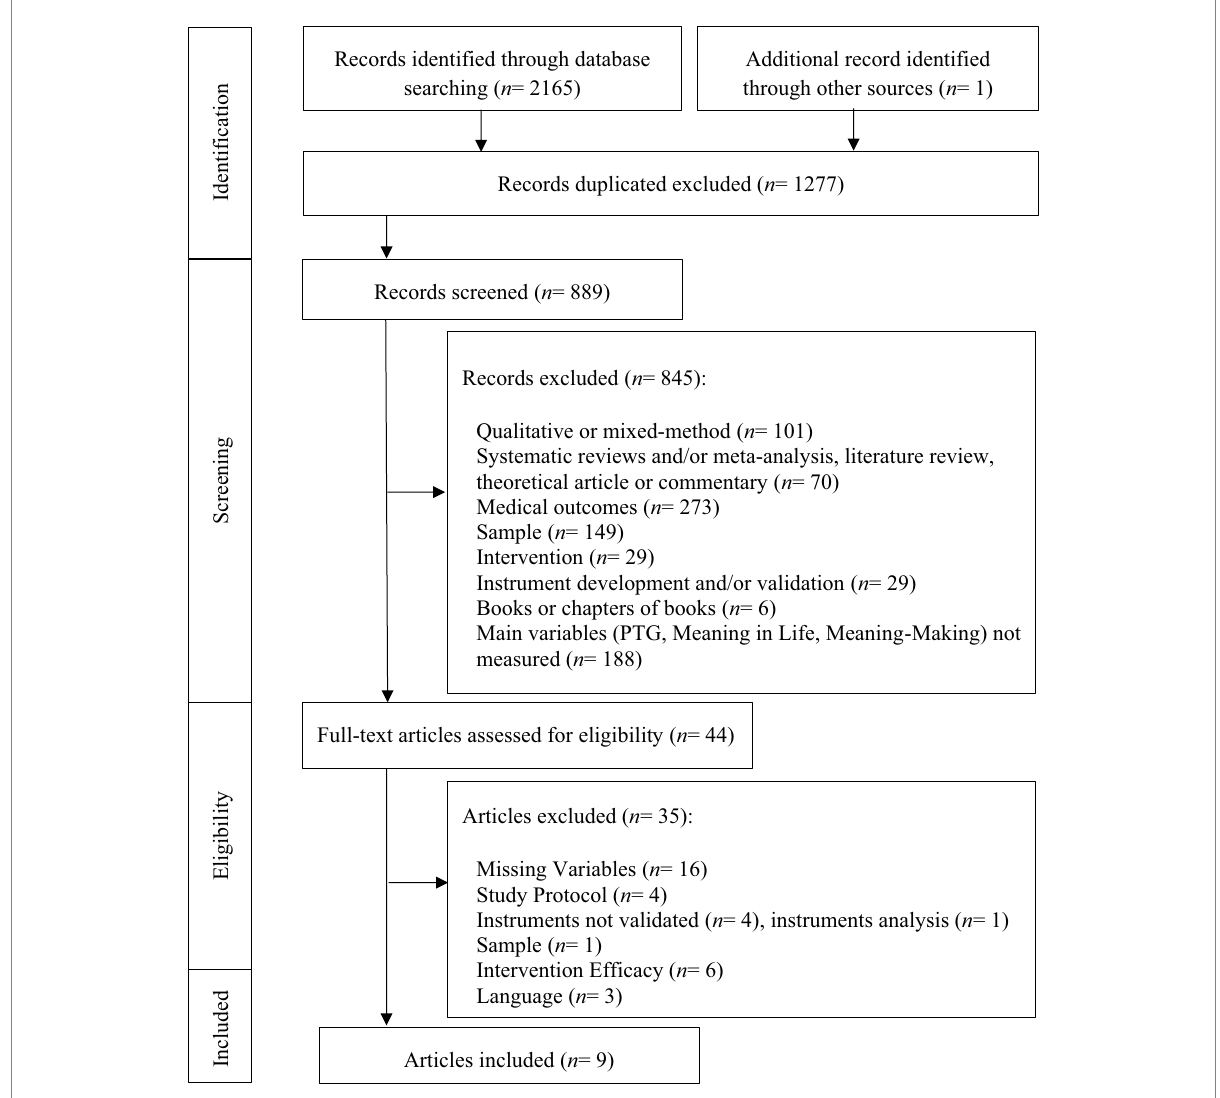
FIGURE 1 Flow diagram displaying the study selection process based on the PRISMA